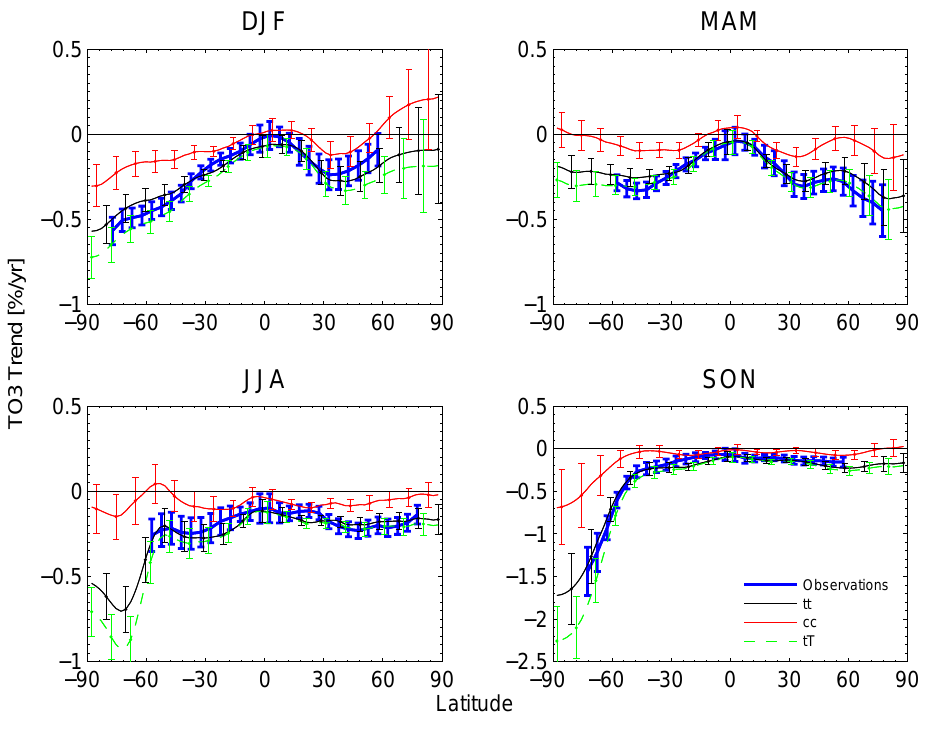
Fig. 7. Modelled TO3 trends in the period 1979–1999 as compared to the combined TOMS/SBUV+GOME/SCIAMACHY/GOME2 TO3 trends (“Observations”), obtained from the time series with solar and aerosol signals removed. Trends from model runs with EESC-dependent chemistry and polar chemistry ( tt , black line, and tT , green dashed line) and constant chemical conditions ( cc , red line) are shown. In tT , the polar ozone destruction rate is scaled ∝ EESC 2 while in tt , it is scaled ∝ EESC. Trends are given in percent of 1980 values per year. Error bars represent the 1 σ variance as obtained from the residuals of the linear